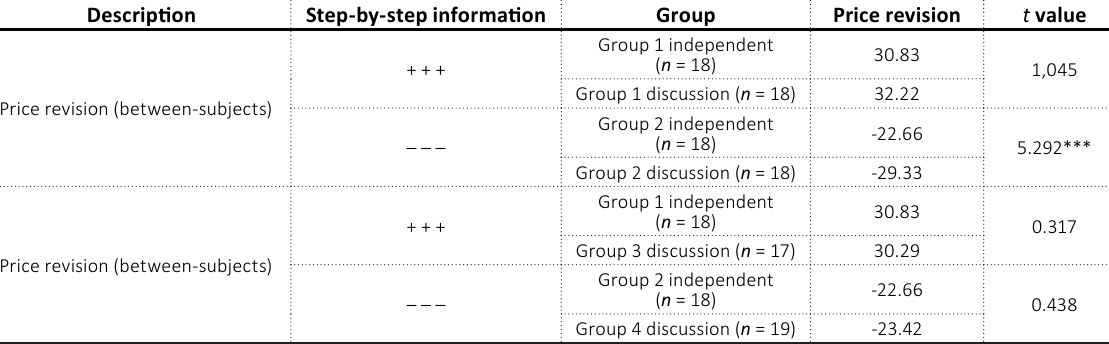
Table 2. The results of price revision using group